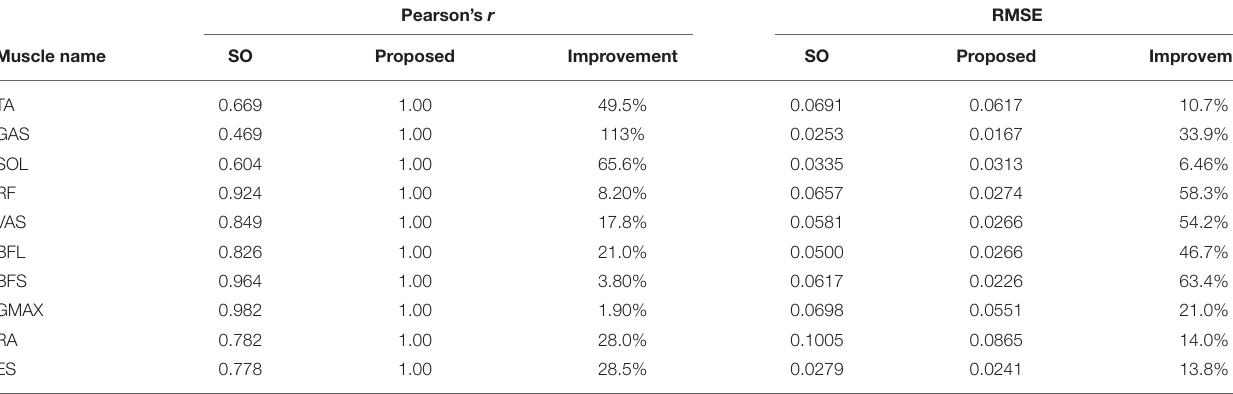
TABLE 1 | Muscle activation simulation results evaluated against measured MVC-normalized EMG from healthy subjects. Pearson’s r RMSE